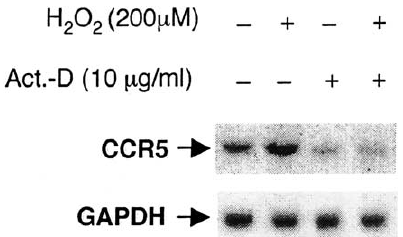
FIG. 4. Effect of Actinomycin D (Act-D) on CCR5 mRNA expression in response to H 2 O 2 . Monocytes were incubated in the absence or presence of Actinomycin D (10 m g/ml) for 15 min before addition of either medium or H 2 O 2 for 3 h. Total RNA was then extracted and analysed by northern blot for CCR5 and GAPDH gene expression. The results are representative of two independent experiments.